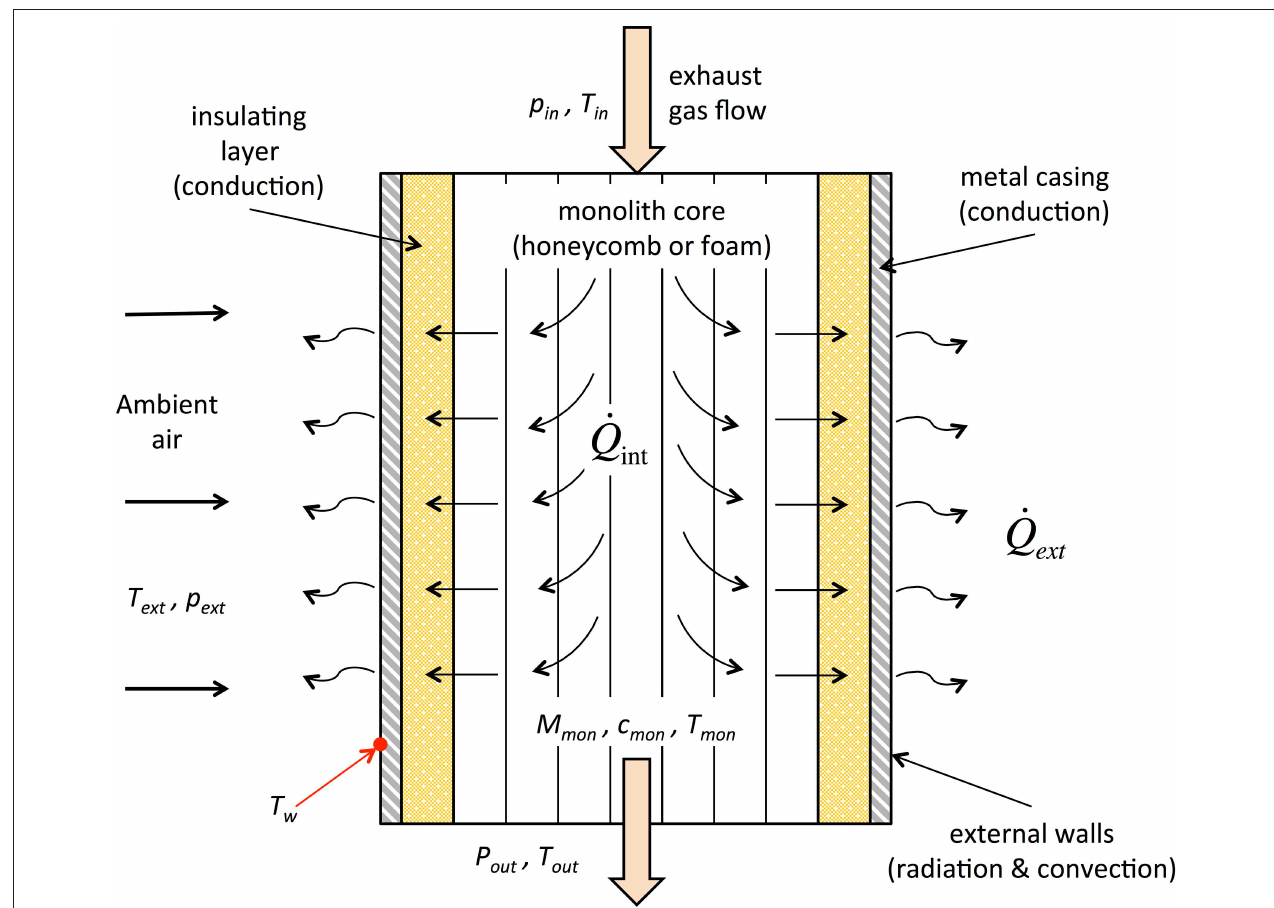
FIGURE 5 | Schematic of flow and heat exchange processes in the catalyst